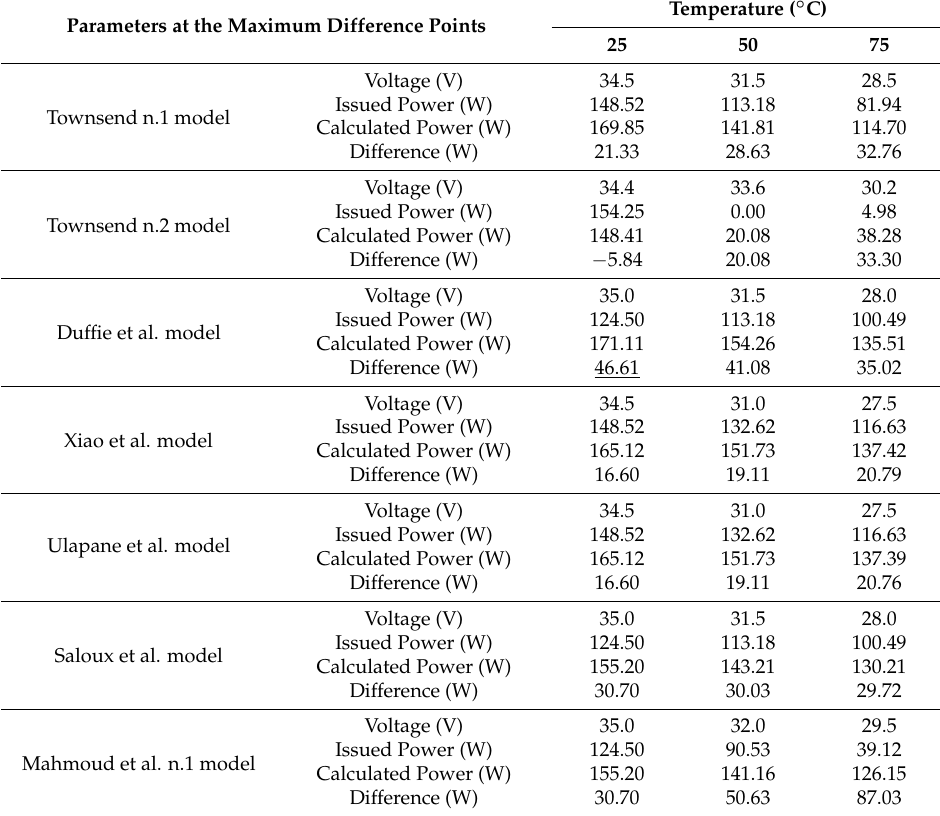
Table 13. Maximum power differences between the calculated and the issued I-V characteristics